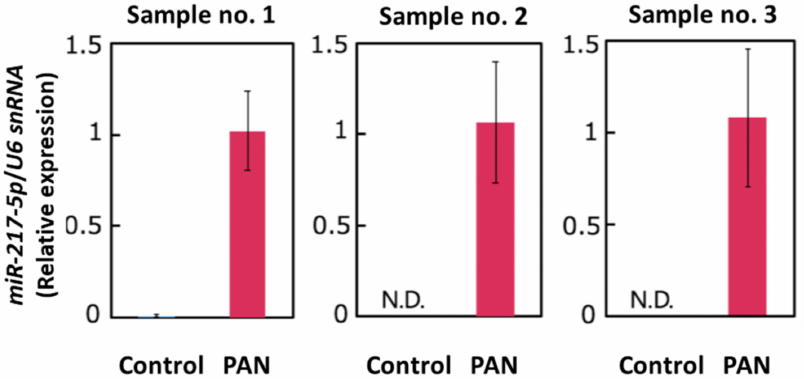
Figure 2. Expression of miR-217-5p in PAN-treated rat podocytes. MiR-217-5p expression level was normalized relative to U6 snRNA expression. The normalized expression level of miR-217-5p at 3 µ g/mL PAN was given an arbitrary value of 1. Data represent the means ± SD (n =